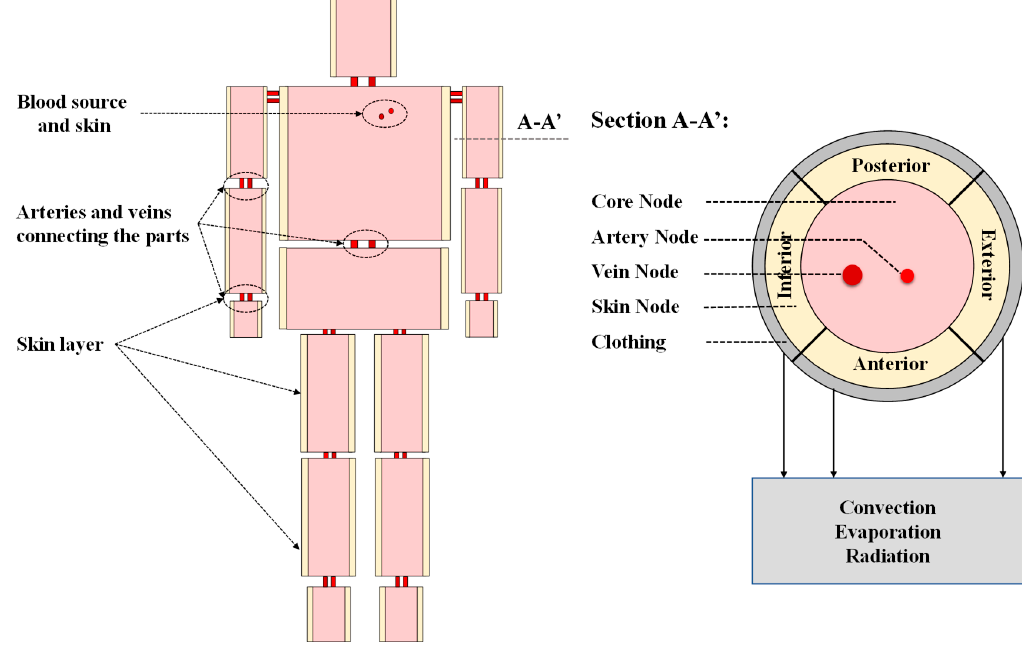
Figure 1. Schematic diagram of the multi-segment multi-node model. Table 1. The detailed parameters of each segment used in the model